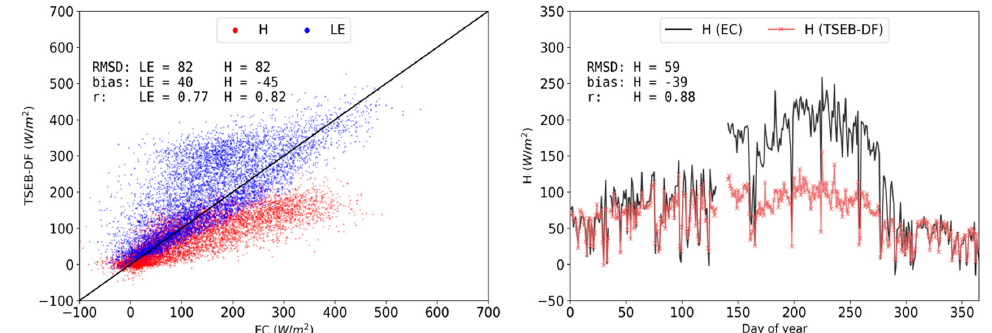
Figure 6. Observed vs modeled daytime half ‐ hourly H (red) and LE (blue) density scatterplot (left) and time series of simulated (red) and observed (black) daytime daily mean H (right) for TSEB ‐ DF in 2015 at CT.